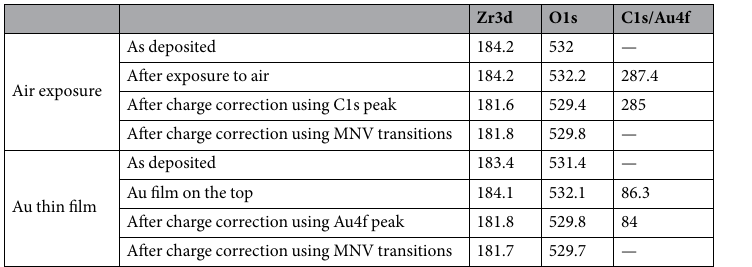
Table 1. BE in eV before and after charge correction for carbon exposed film and Au film deposited on the